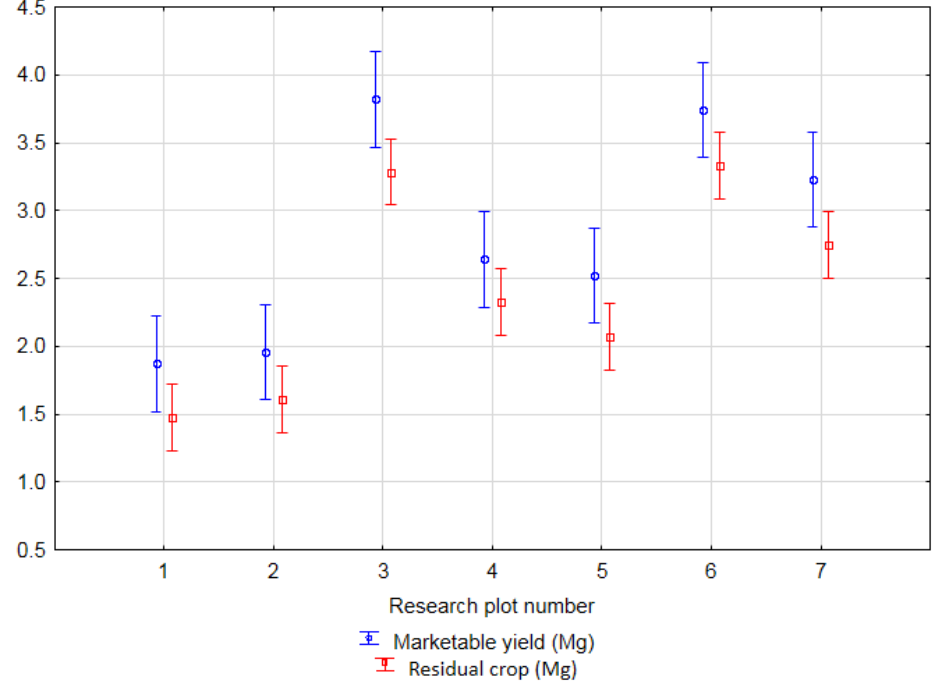
Figure 3. Average values of soybean yield (Mg) depending on the type and dosage of biochar. Table 7. The results of Tukey’s test for groups of significantly homogeneous grouping factor (****) of biochar dose and soybean